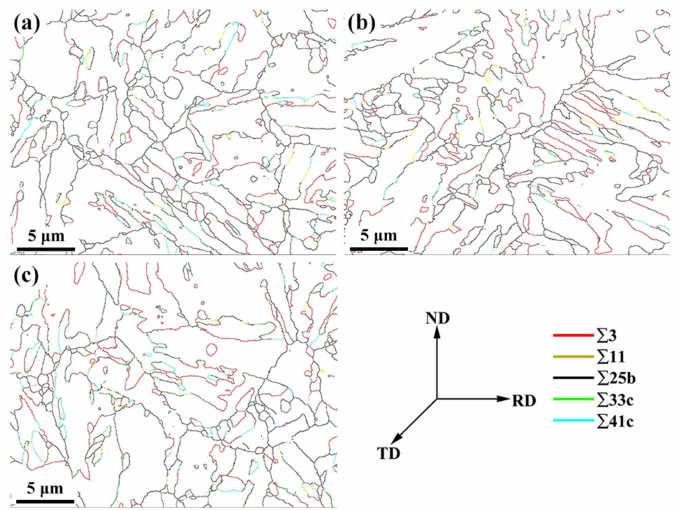
Figure 8. CSL maps of the 0.5Cr0.4W steels tempered at ( a ) 690 ◦ C, ( b ) 700 ◦ C, and ( c ) 715 ◦ C.